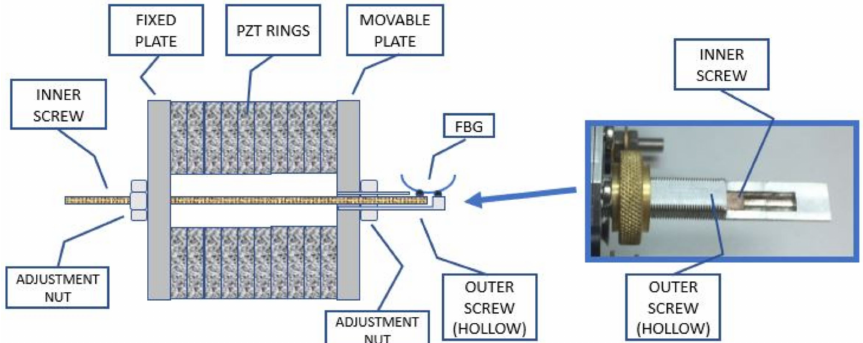
Figure 1. Method used to apply an FBG to monitor the PZT ring stack. The box on the right shows an enlarged picture of the tips of the screws, between which the FBG was bonded (FBG not show). Figure 2 shows a picture of the OVT assembly with all components.